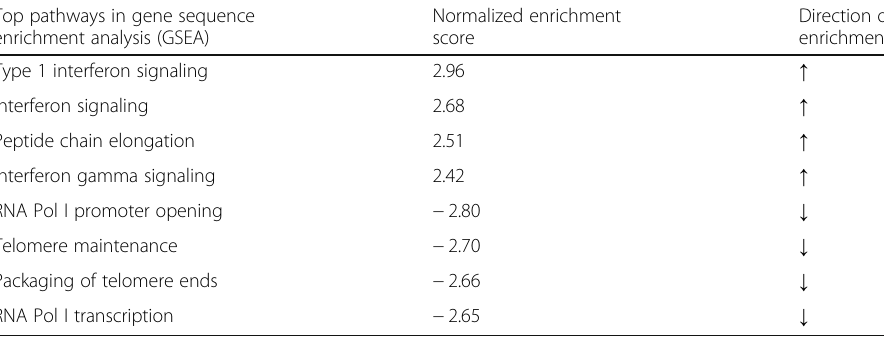
Table 2 Top pathways in gene sequence enrichment analysis (GSEA) Top pathways in gene sequence Normalized enrichment Direction of enrichment analysis (GSEA) score enrichment Type 1 interferon signaling 2.96 ↑ Interferon signaling 2.68 ↑ Peptide chain elongation 2.51 ↑ Interferon gamma signaling 2.42 ↑ RNA Pol I promoter opening − 2.80 ↓ Telomere maintenance − 2.70 ↓ Packaging of telomere ends − 2.66 ↓ RNA Pol I transcription − 2.65 ↓ Adjusted p <0.05 for all pathways